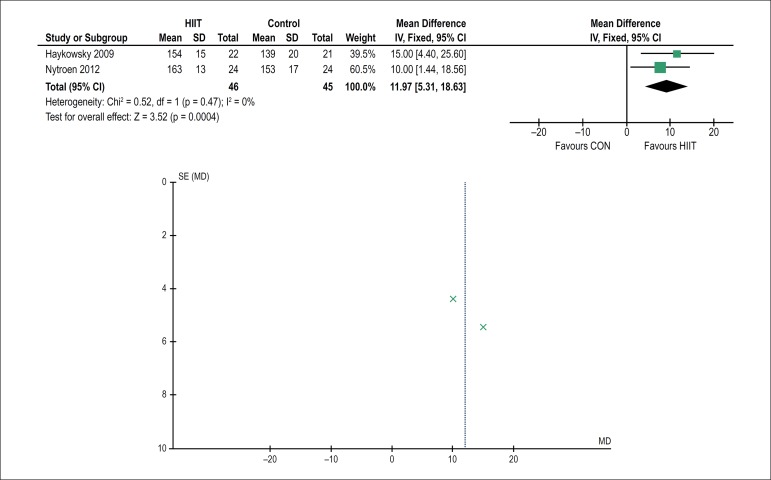
Forest plot (A) AND funnel plot (B) showing information about the effect
of high-intensity interval training (HIIT) on peak heart rate.